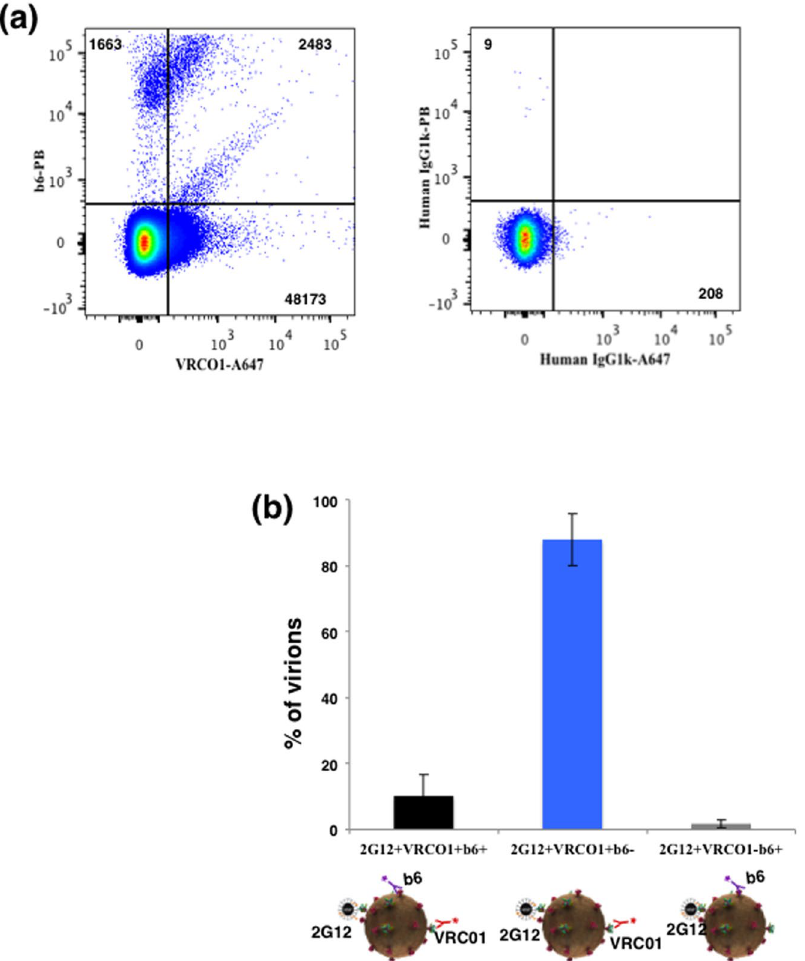
Figure 2. Flow virometry of HIV-1 BaL virions captured with 2G12-MNPs. ( a ) Virions were captured with 2G12- MNPs and stained with: AlexaFluor 647-labeled VRC01, which predominantly recognizes trimeric Envs and Pacific Blue-labeled b6, which recognizes uncleaved and non-trimeric Envs (left panel) or with isotype control antibodies (right panel). Indicated are the numbers of events. A representative experiment out of three is shown. ( b ) Distribution of 2G12-captured virions positive for VRC01 (recognizing predominantly trimeric Envs) and/or for b6 (recognizing predominantly uncleaved and non trimeric forms of Envs). Each bar represents mean ± SEM of three